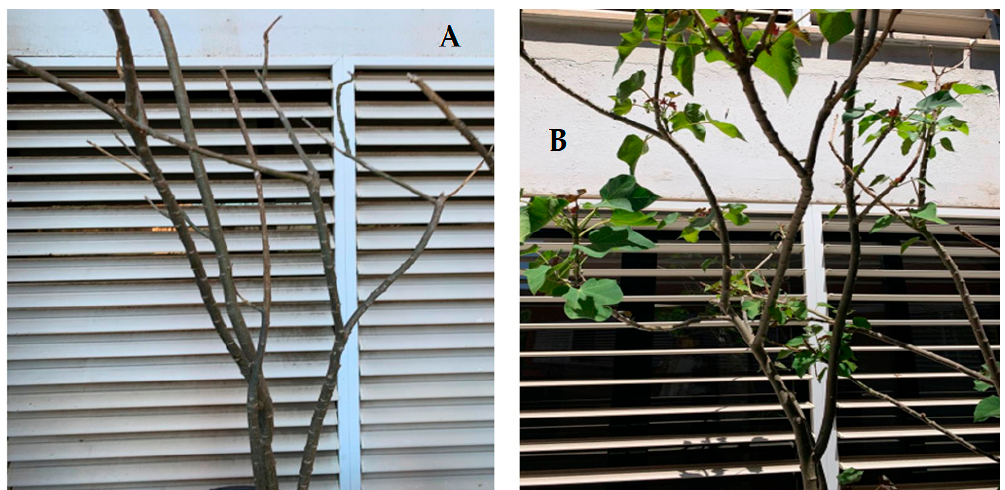
Figure 3. J. curcas L. in NCS ( A ) and in CS ( B ) after 90 days.